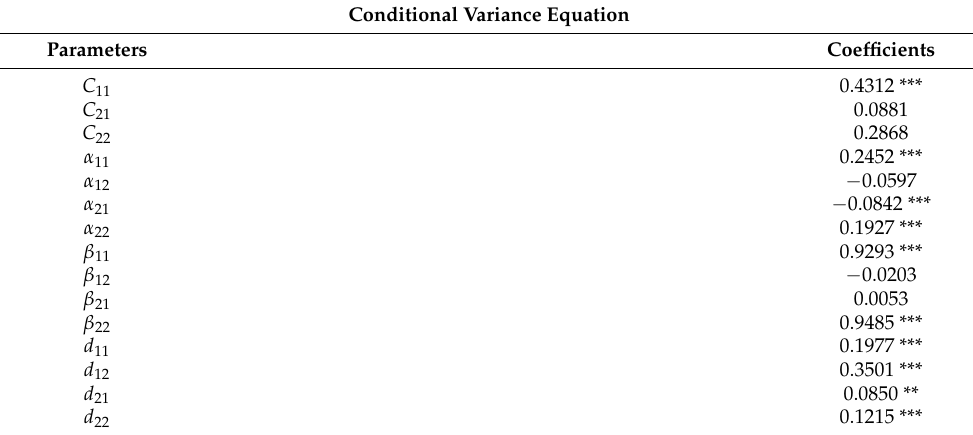
Table 5. Volatility spillover between the JSE (rJSE) and yen-funded carry trade (rCT/yen) returns.